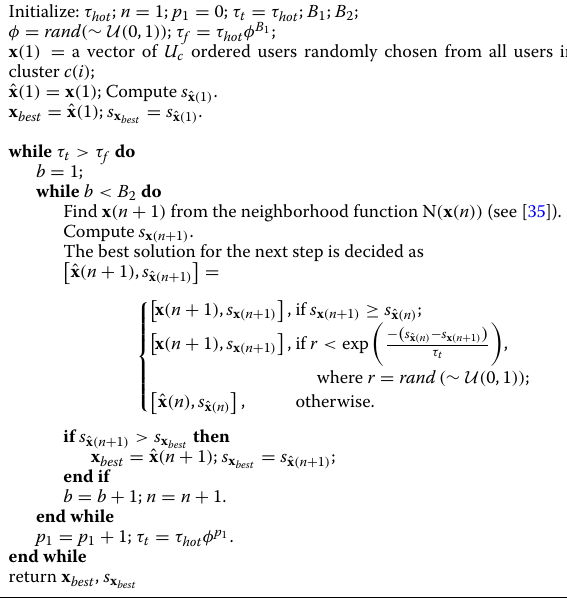
Algorithm 1 Simulated Annealing Scheduling (SAS) Algorithm for Coordinated MIMO